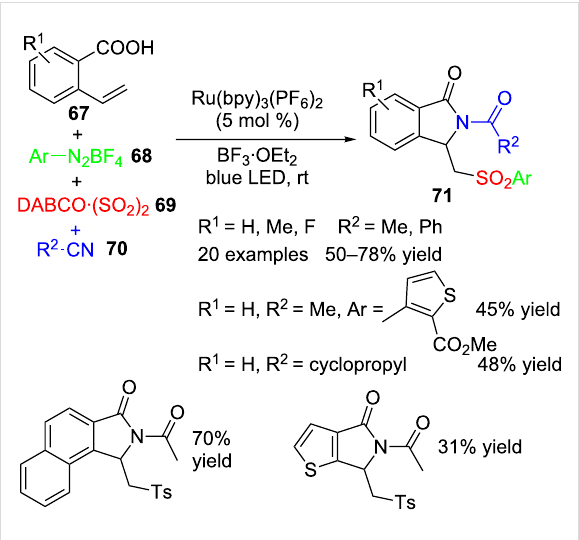
Scheme 21: Four-component reaction of 2-vinylbenzoic acids 67 , aryl- dioazonium tetrafluoroborates 68 , DABCO·(SO 2 ) 2 ( 69 ) and nitriles 70 . would add to the nucleophilic nitrile 70 . Intramolecular nucleo- philic attack of the carboxy group in 75 followed by rearrange- ment of intermediate 76 delivered isoindolinone derivatives 71 .